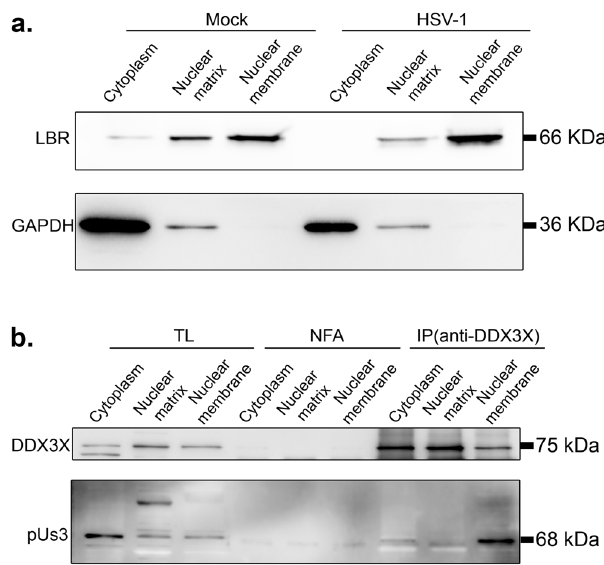
Fig. 10 DDX3X physically interacts with pU S 3. HeLa cells were either mock treated or infected with wild-type strain 17 + virus for 12 h. Cells were then fractionated into cytoplasm, nuclear matrix and nuclear membranes as detailed in Methods and a probed by WB for the GAPDH and LBR cytoplasmic and nuclear membrane markers respectively and b used to immunoprecipitate DDX3X using the R648 polyclonal serum and monitored for the presence of pU S 3. NFA: no fi rst antibody. In parallel, total lysates were loaded on the gels. Results represent three independent